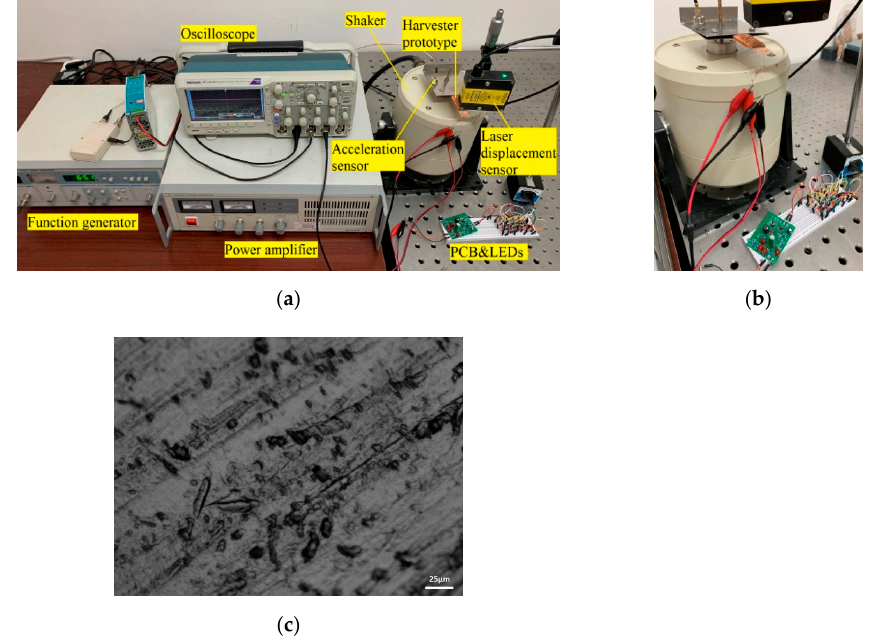
Figure 5. Photographs of experimental setup and harvester prototype: ( a ) Experimental setup; ( b ) a close-up of the actual fabricated harvester prototype; ( c ) SEM picture of the Fe-Ga material. A Sinocera Piezotronics CA-YD-181 acceleration sensor with a sensitivity of 3 pc/g measures the time-varying vibration acceleration of the harvester. The signals of the laser sensor, acceleration sensor, and harvester’s output voltage are recorded by the three di ff erent channels of a DPO2014B digital phosphor oscilloscope (Tektronix, Tektronix Inc. Beaverton, OR,